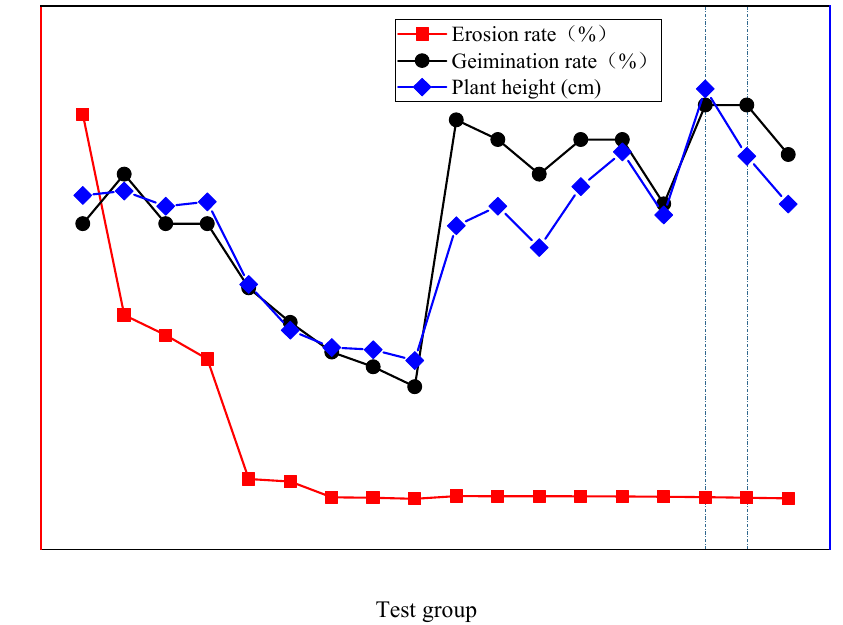
Figure 12. Improvement of SPC with the addition of polymer composite material.